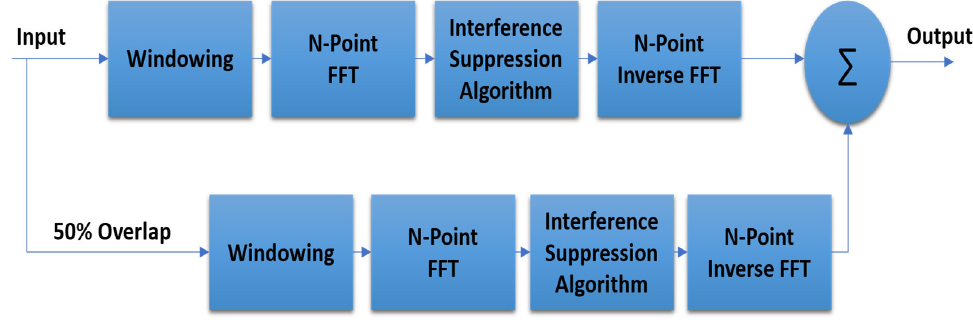
Figure 8. Proposed FFT mitigation algorithm .